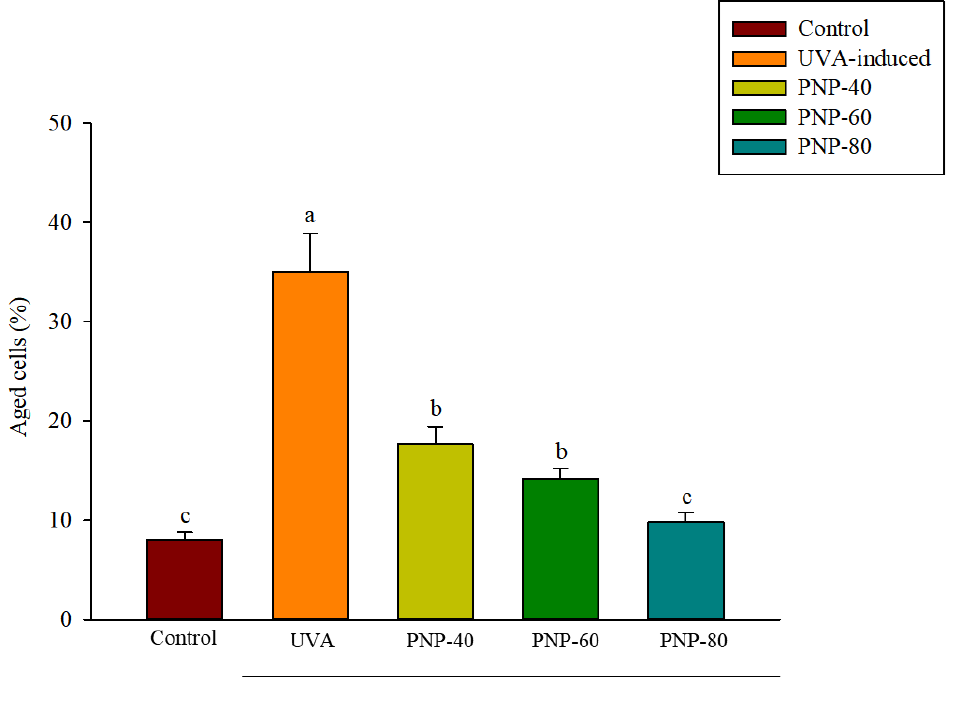
Figure 6. Protective effect of PNPs against cellular senescence in Hs68 cells irradiated with UVA. Experiments were conducted in triplicate ( n = 3). Data are expressed as the mean ± SD. a–c: Matching lowercase letters indicate significant difference between the different groups ( p < 0.05).